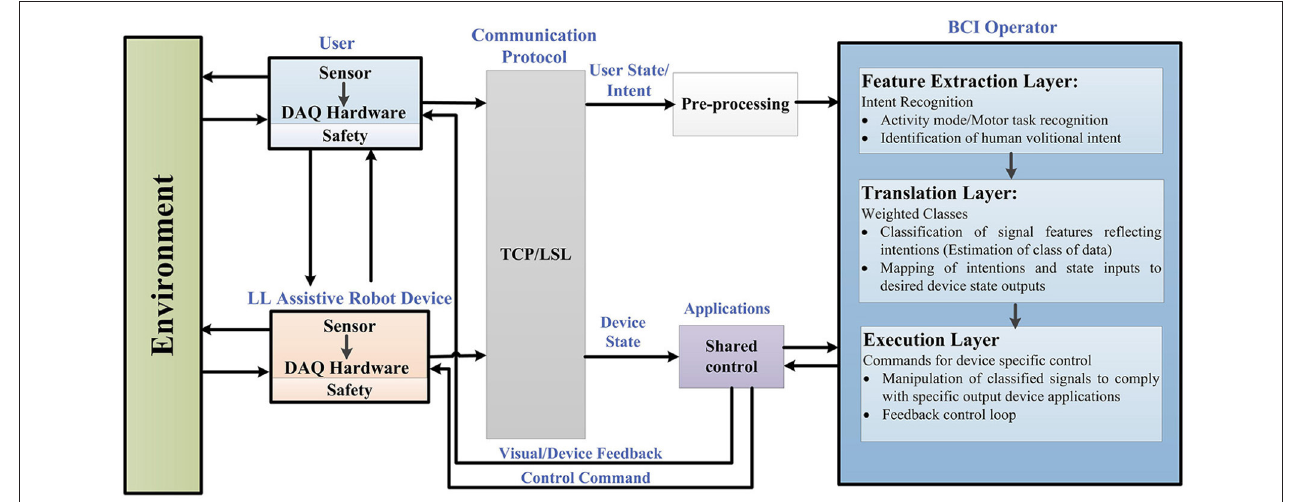
FIGURE 2 | Generalized framework in BCI controlled wearable LL and assistive devices for rehabilitation.